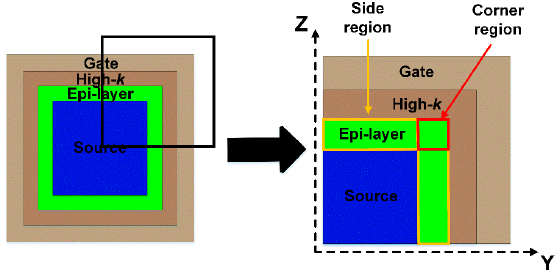
Figure 4. Definition of corner and side of a nanowire (NW).